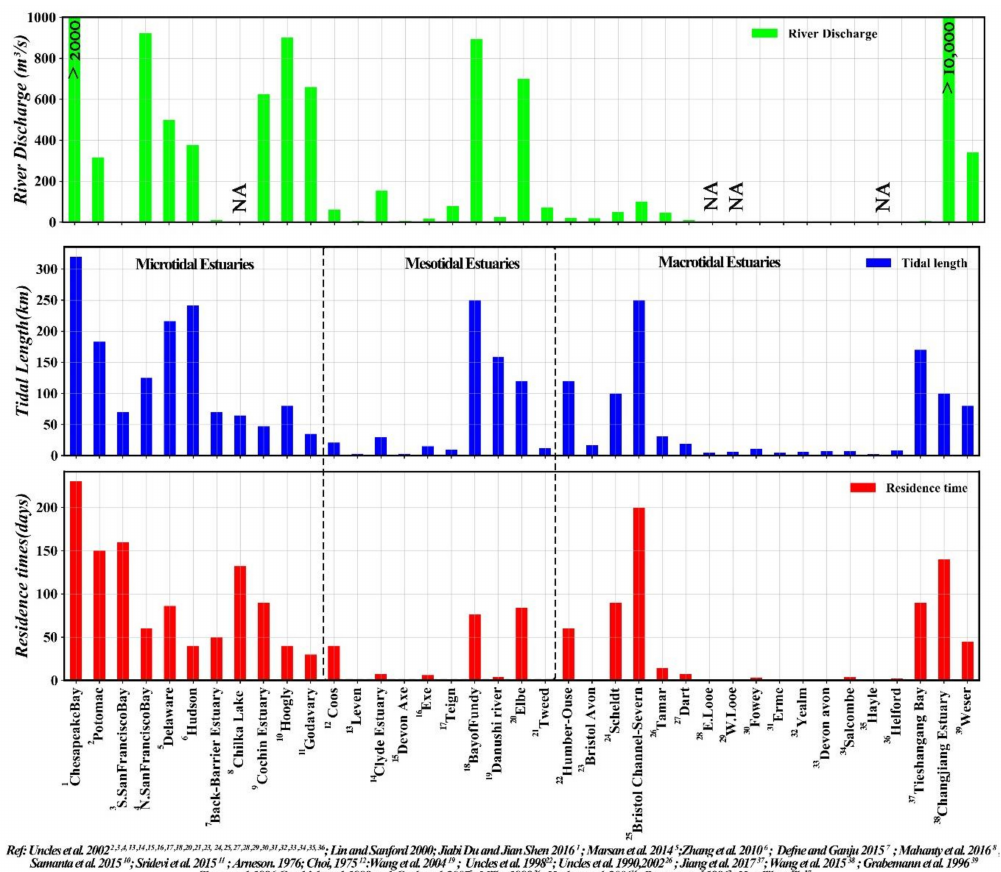
Figure 20. Comparison of residence time, tidal length and mean river discharge of the various estuaries in the world [30,32–50]. NA in the graph corresponds to “not available” discharge data, and two of the estuarine river discharges exceed more than 1000 m 3 / s, therefore the values are marked in the plot ( > 2000 m 3 / s and > 10,000 m 3 /